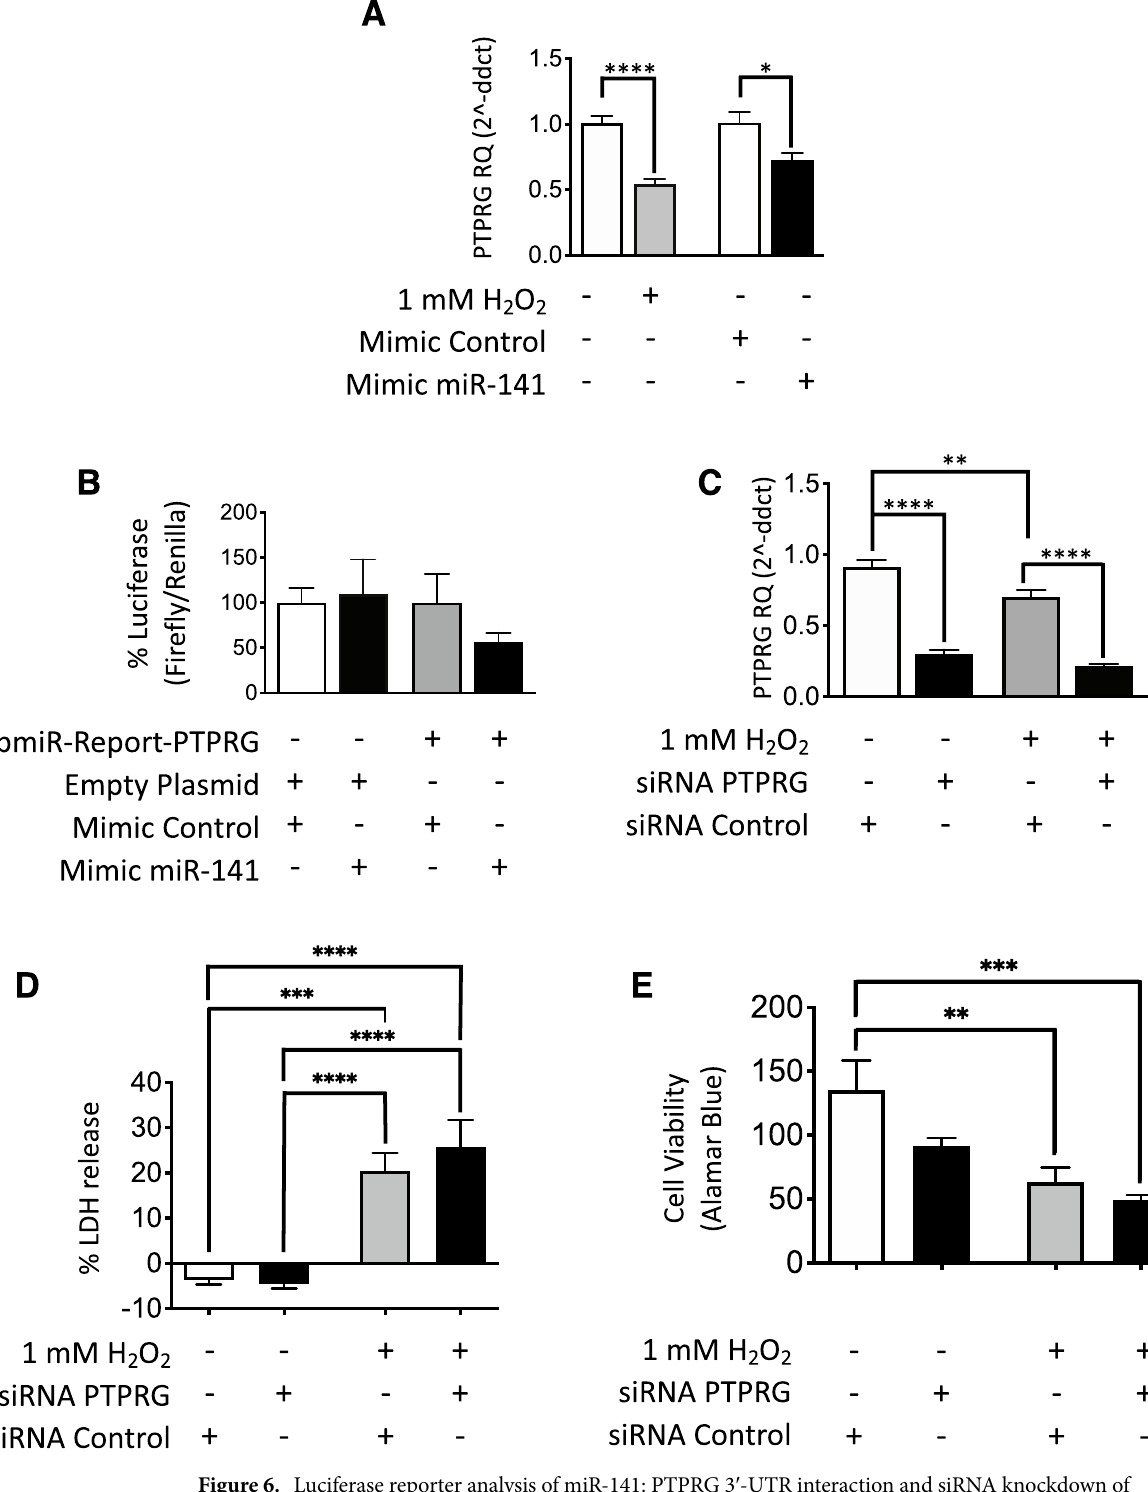
Figure 6. Luciferase reporter analysis of miR-141: PTPRG 3 ′ -UTR interaction and siRNA knockdown of PTPRG in PTECs in response to oxidative stress and forced miR-141 expression. ( A ) RT-qPCR analysis of PTPRG showed significant downregulation in 1 mM H 2 O 2 (50% decrease) and following forced miR-141 expression (30% decrease). ( B ) PTPRG 3 ′ -UTR reporter assay activity in PTECs showed PTPRG to be a direct miR-141 target. ( C ) RT-qPCR analysis showed significant PTPRG mRNA knockdown using siRNA, as well as repression of PTPRG in 1 mM H 2 O 2 compared to healthy cells. ( D ) LDH release increased significantly under oxidative stress and showed a further increase with PTPRG knockdown. ( E ) Cell viability marker Alamar Blue decreased in 1 mM H 2 O 2 , lowering further following PTPRG knockdown. Statistical analysis between groups was carried out using one-way ANOVA with post-hoc analysis of Tukey (n = 3). Data are presented as mean ± SEM; *p < 0.05, **p < 0.01, ***p < 0.001, ****p <